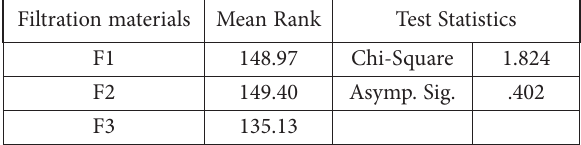
Table 8. Kruskal-Wallis rank test results of the